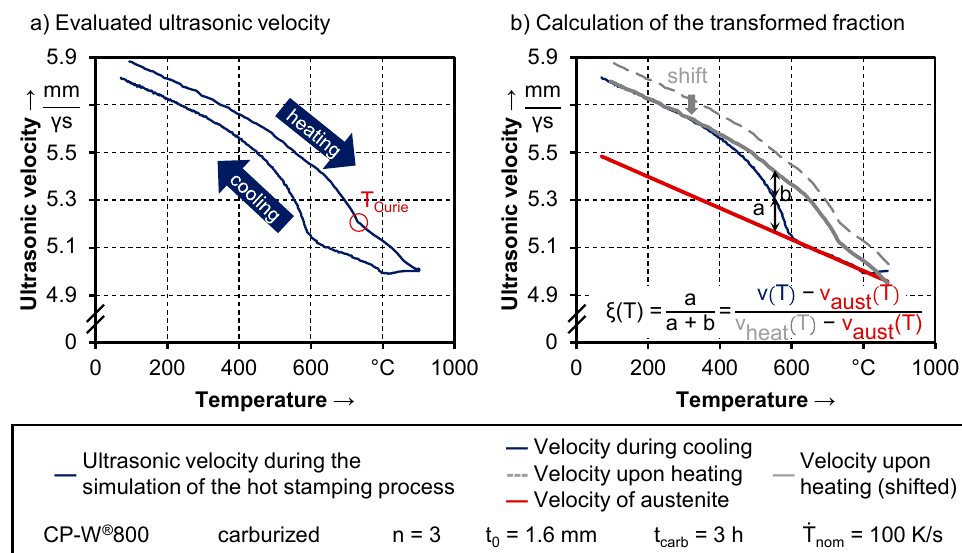
Figure 4. ( a ) Results from the measured ultrasonic velocity and ( b ) calculation of the transformed fraction.